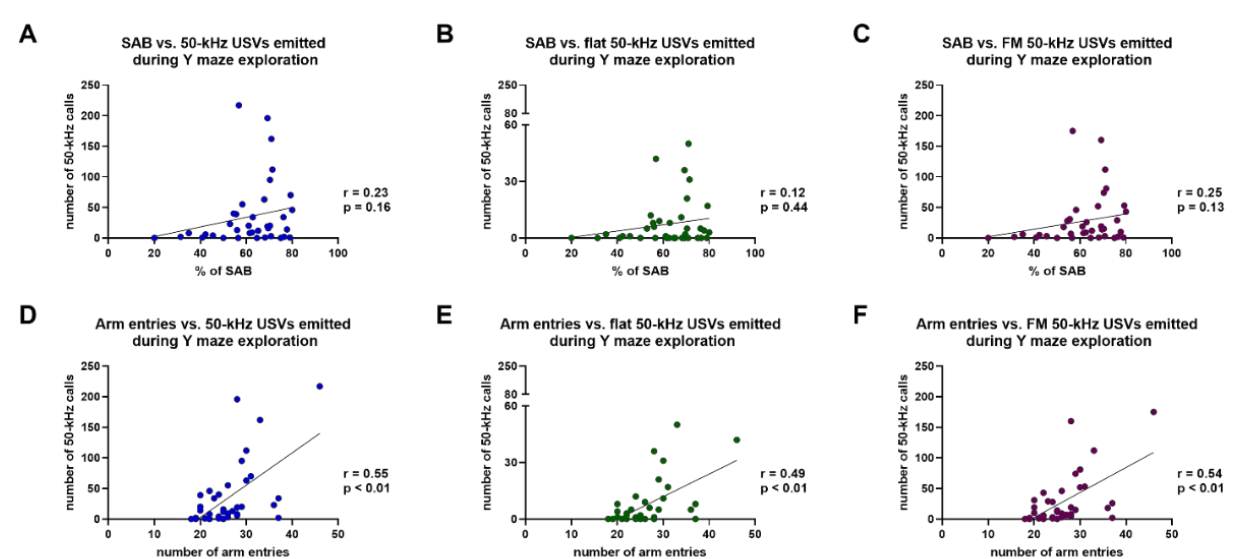
Figure 7. Results of Spearman’s correlation test of the percentages of spontaneous alternation behavior ( A – C ) or the number of entries in the arms of the Y maze ( D – F ) and the number of total, flat, or frequency-modulated 50-kHz ultrasonic vocalizations emitted during the exploration of the Y maze. FM = frequency-modulated; SAB = spontaneous alternation behavior; USVs = ultrasonic vocalizations. n = 38.